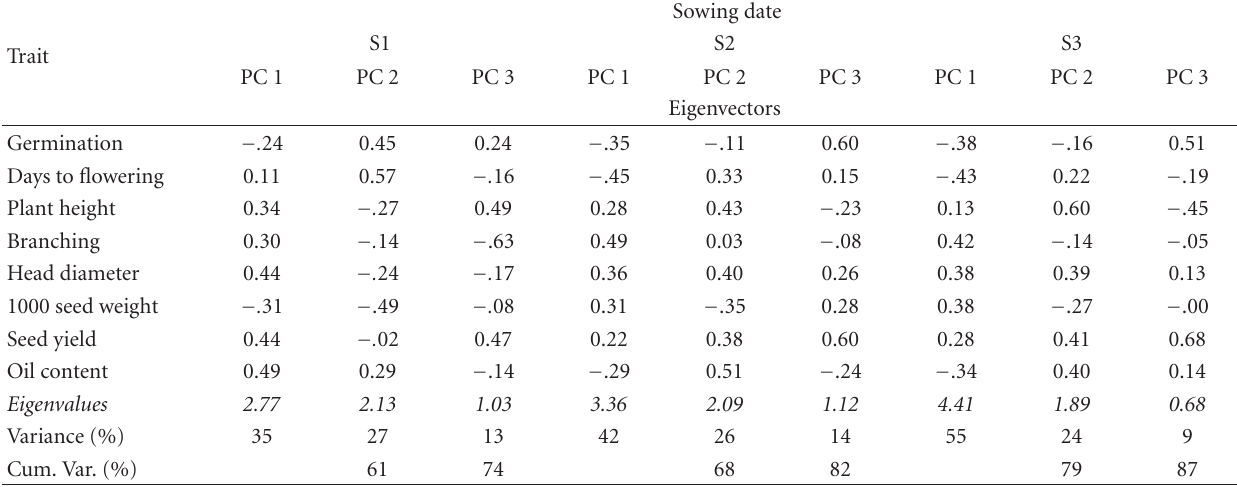
Table 5: Principal component analysis of traits associated with eleven sunflower hybrids showing eigenvalues and proportion of variation relating to the first three principal component axes and eigenvectors of traits in three sowing dates and over three location-year combinations.